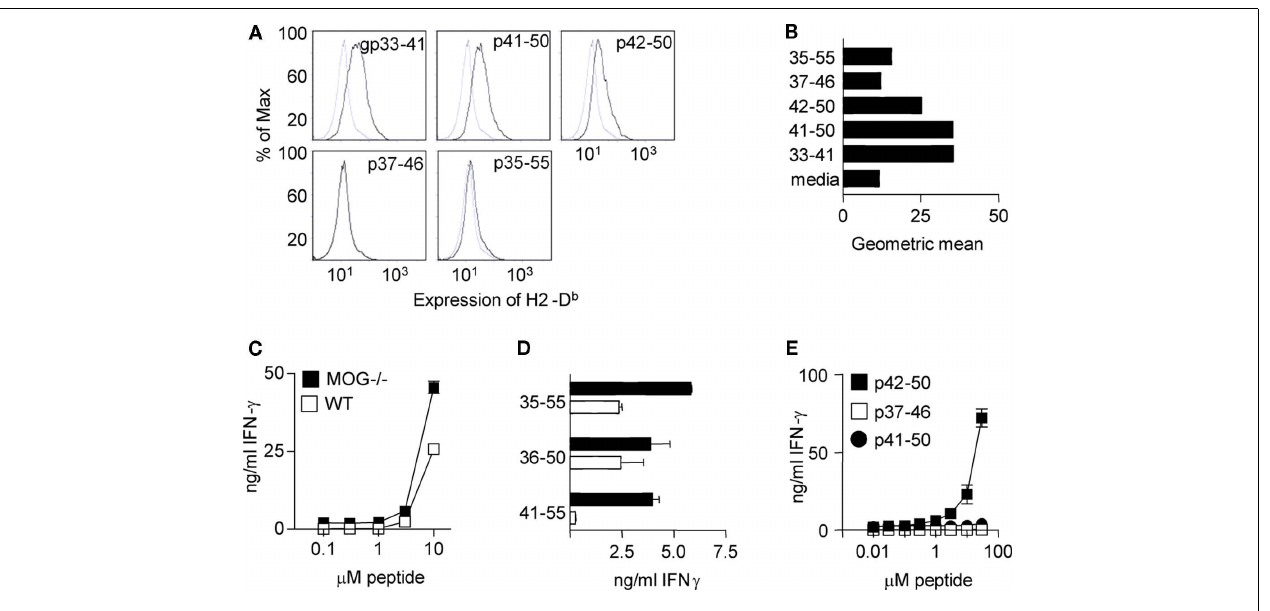
FIGURE 5 |The CD8+T cell response in MOG − / − mice focuses on an epitope with high affinity for D b . (A) RMA-s cells were cultured with the indicated peptides and expression of Db assessed by flow cytometry (B) shows the geometric mean fluorescence (MFI). Mice were immunized with 100 μ g pMOG in CFA.Ten days later, CD8 + T cell lines were derived by